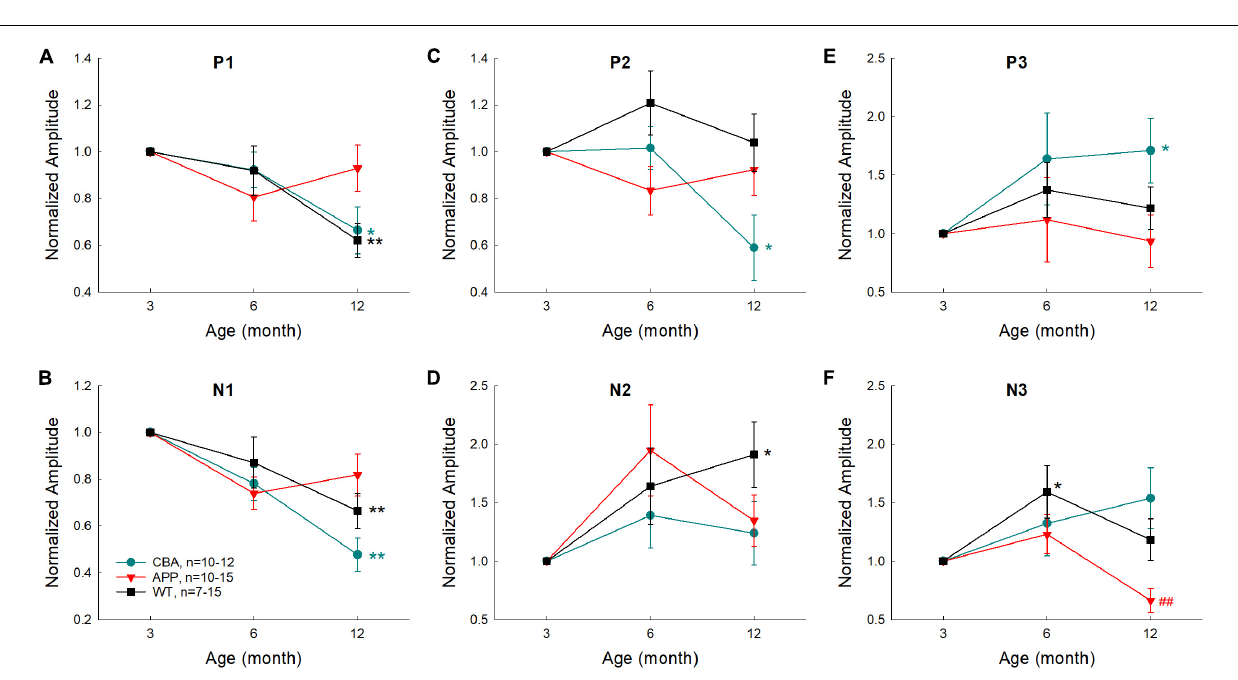
Frontiers in Aging Neuroscience |